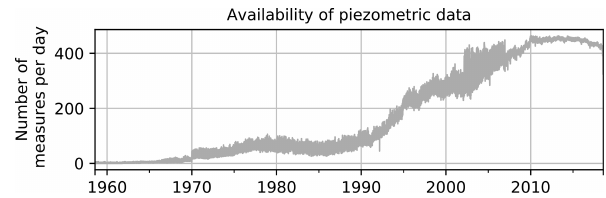
Figure 5. Temporal evolution of the number of piezometric-head measurements per day among the 639 selected piezometers over the 1958–2018 simulated period.